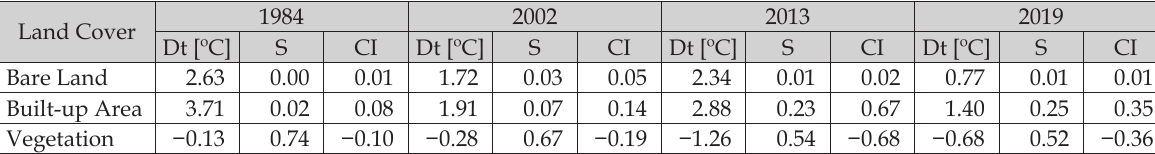
Fig. 13. CI plot of vegetation against bare land between 1984 and Table 11. Contribution index (CI).